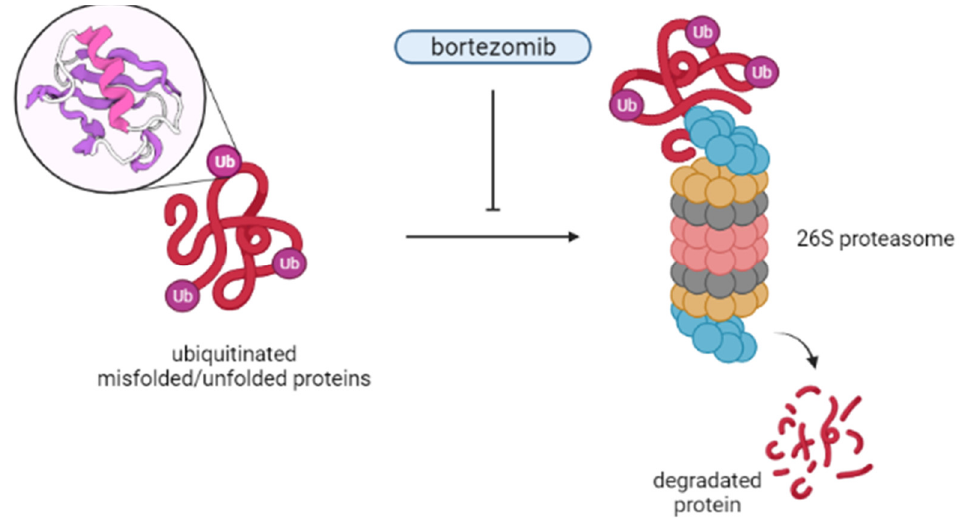
Figure 6. Bortezomib mechanism of action.